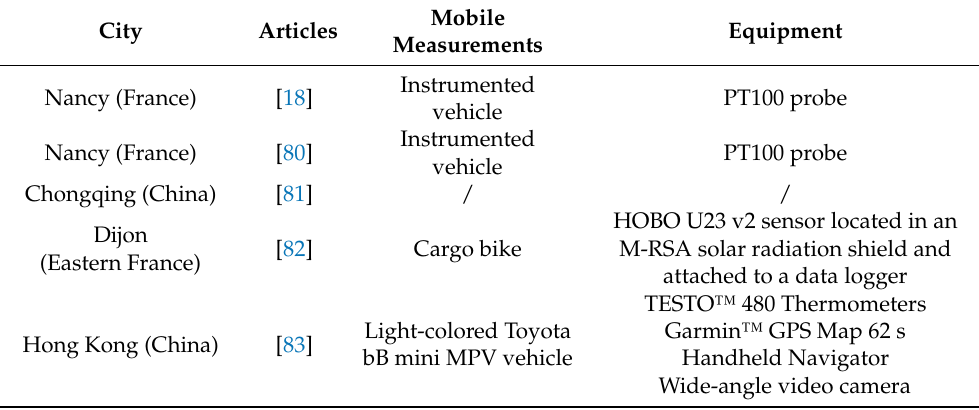
Table 5. Mobile measurements used in LCZ